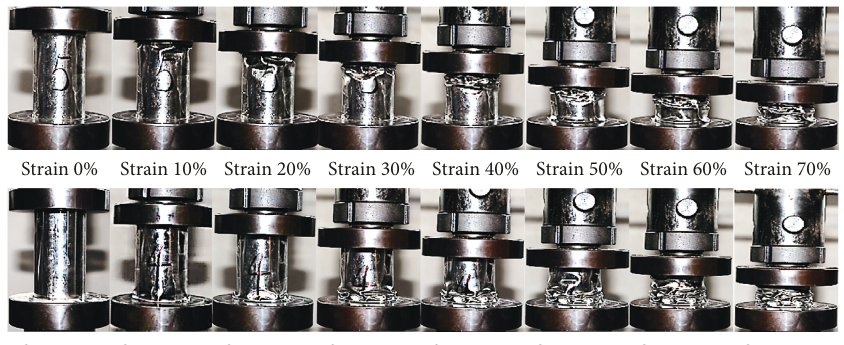
Figure 5: Sequence showing the results of compression on the deformation of epoxy-bonding APM composite pipes.